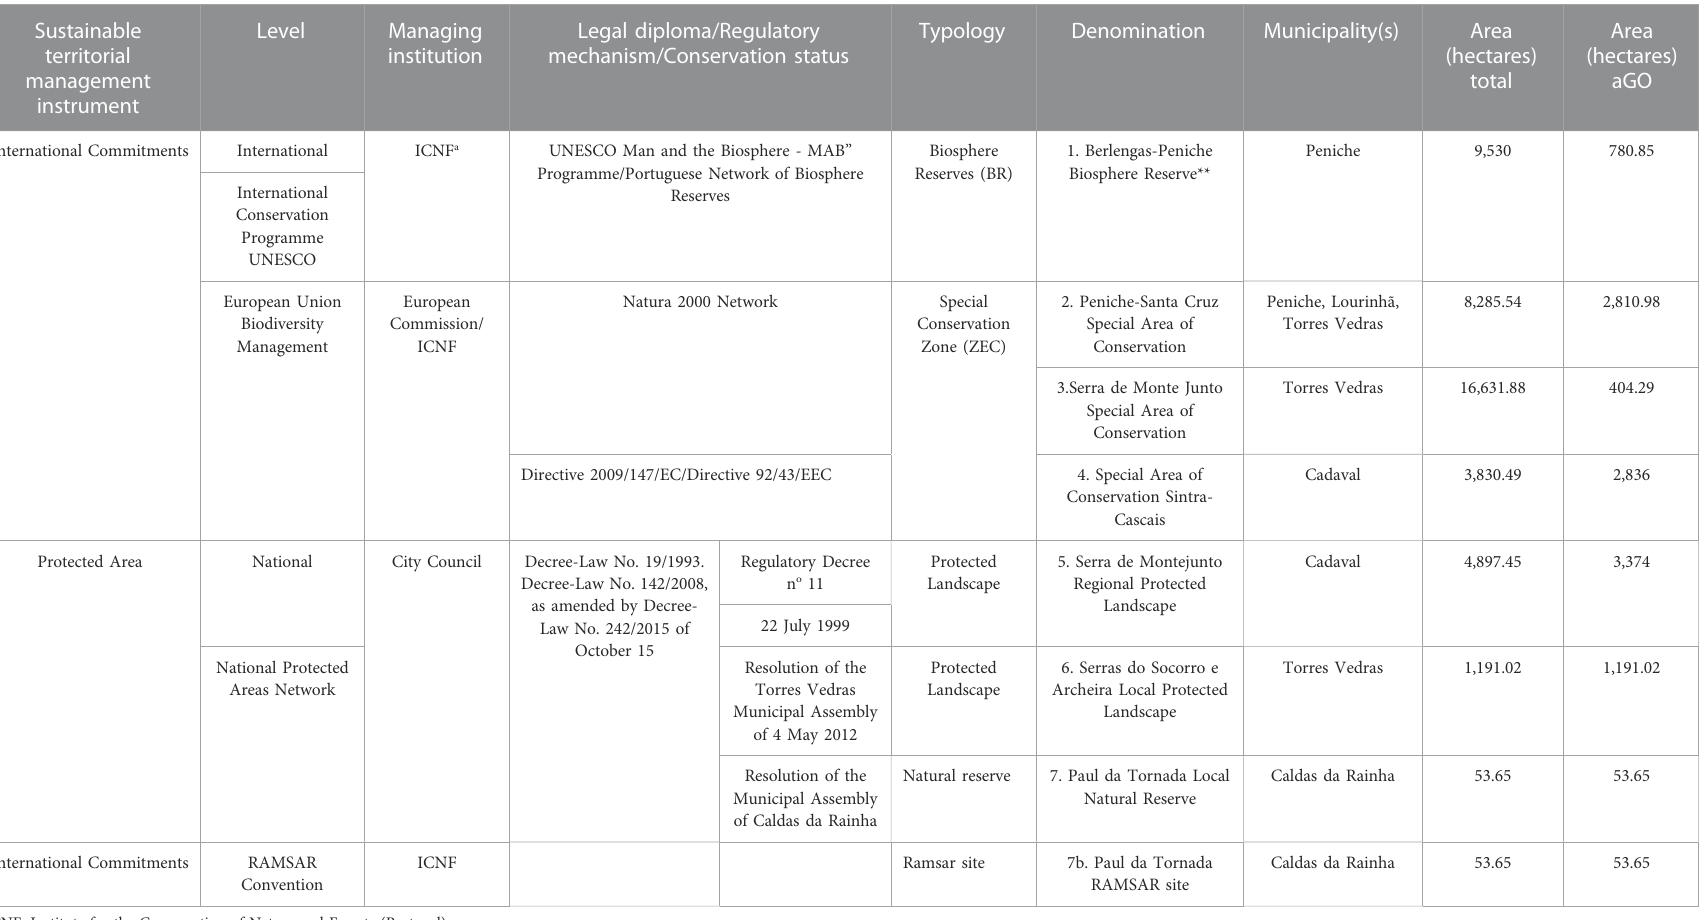
TABLE 1 Areas designated for sustainable territorial management according to Portugal ’ s national system of classi fi ed areas (nuclear areas) within the aGO territory. Source: Own